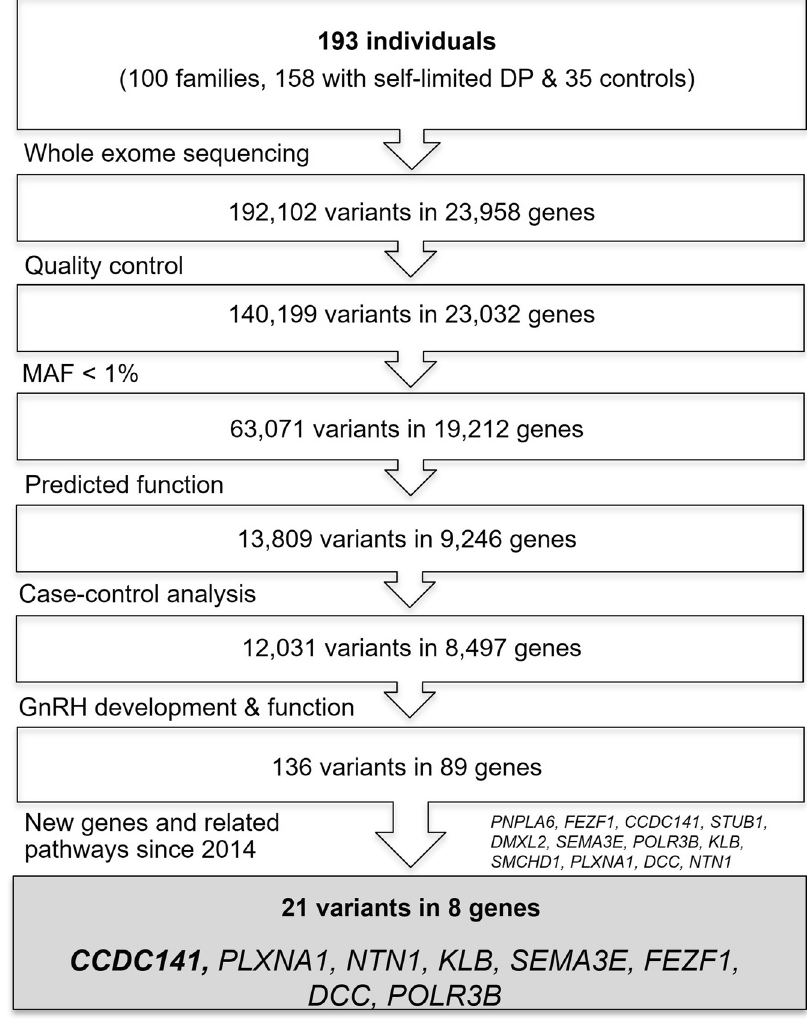
Fig. 1 Whole exome sequencing analysis pipeline. Analytic pipeline for genetic analysis in self-limited delayed puberty pedigrees, focusing on genes reported in the literature to cause IHH since 2014 18,36